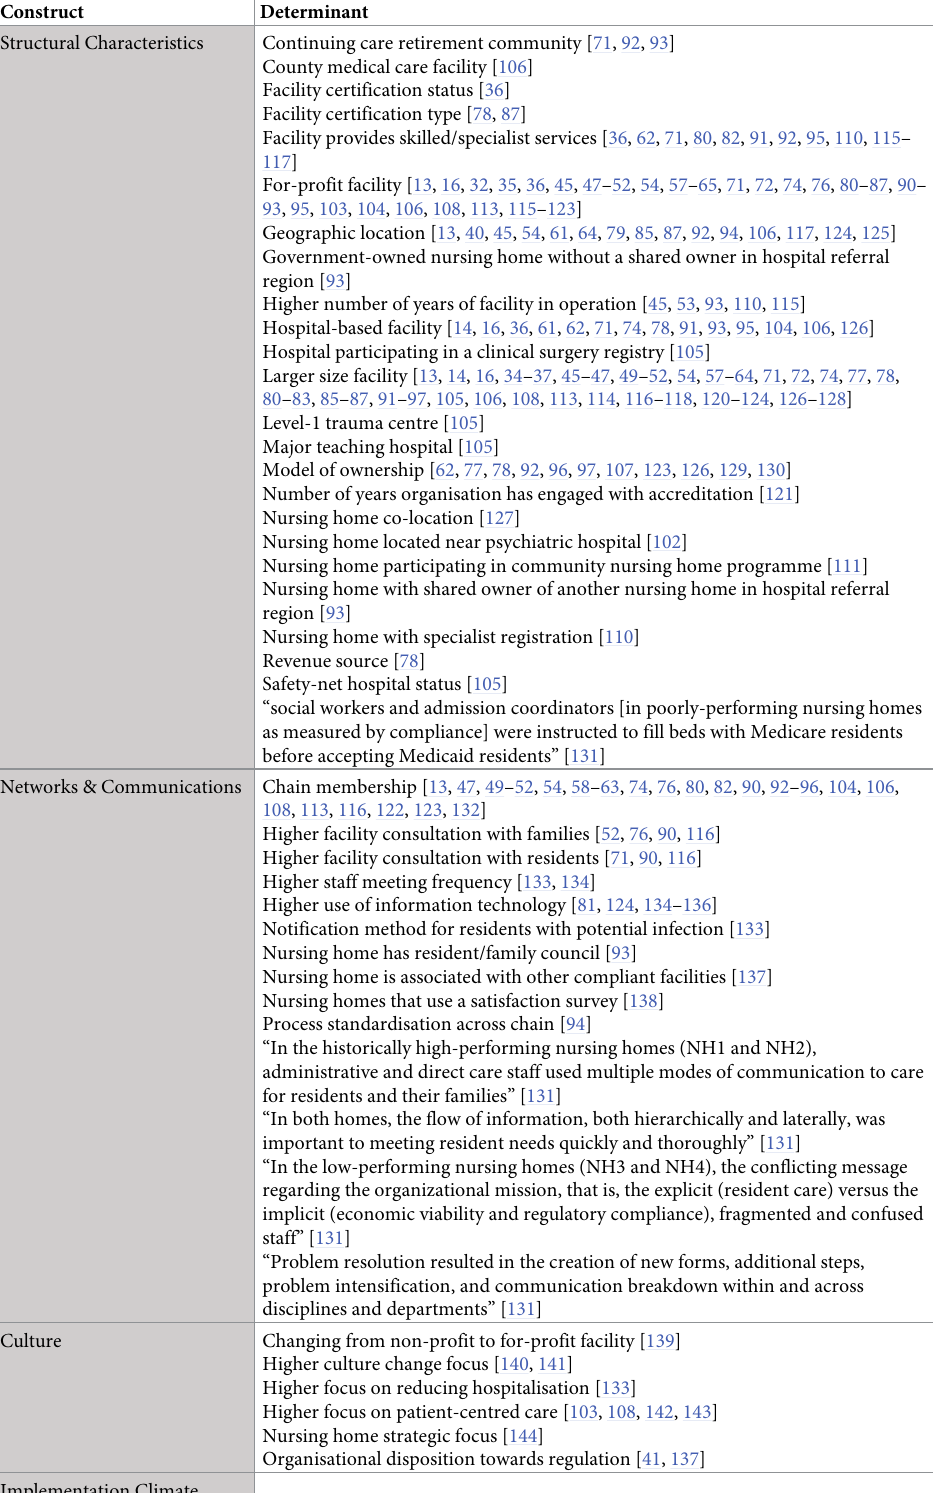
Table 4. Determinants coded to the inner setting